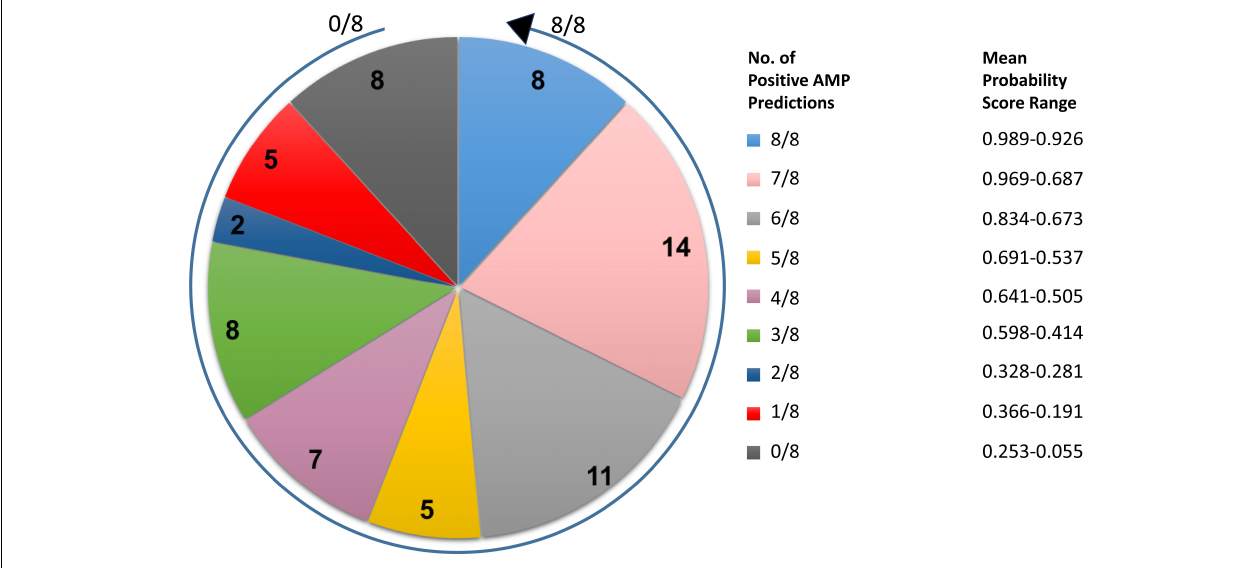
Frontiers in Microbiology |